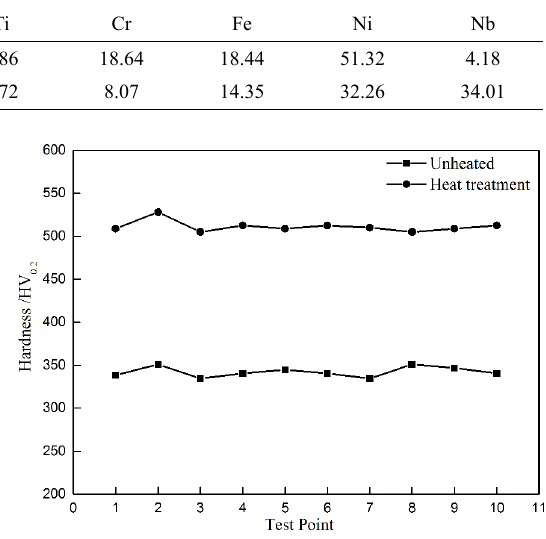
Table 1. The EDS analysis of precipitates in the Z-Y surface of alloys (wt. %). Location